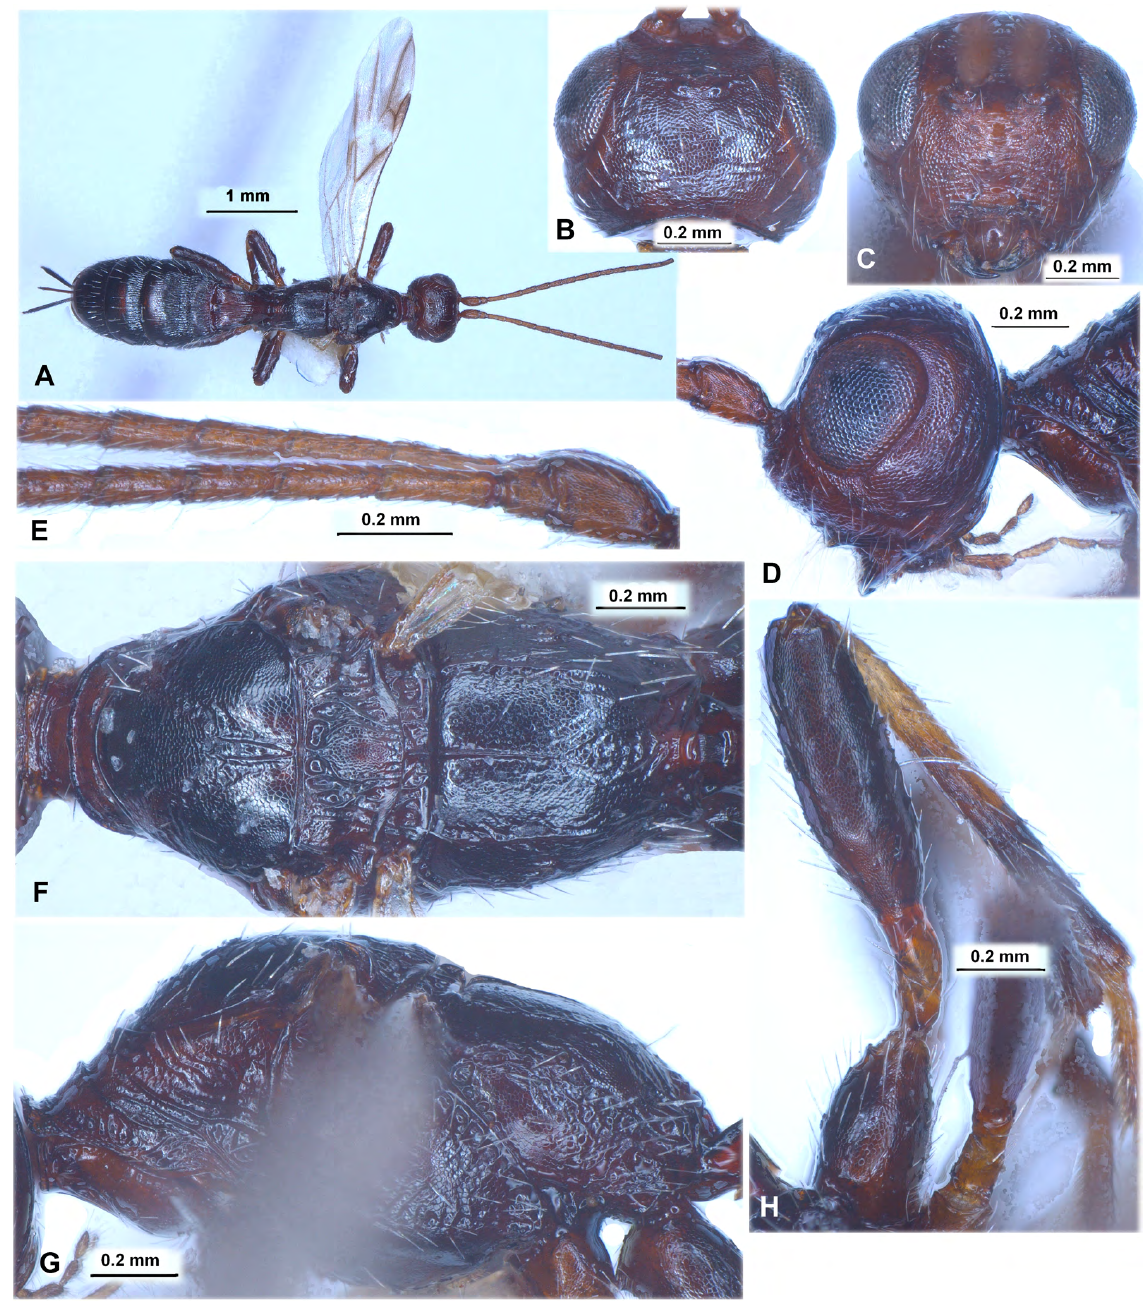
Fig. 38. Pseudorhaconotus enervatus van Achterberg & Shaw, 2010, ♀, holotype, NMS. A . Habitus, dorsal view. B . Head, dorsal view. C . Head, front view. D . Head, lateral view. E . Basal segments of antenna. F . Mesosoma, dorsal view. G . Mesosoma, lateral view. H . Hind